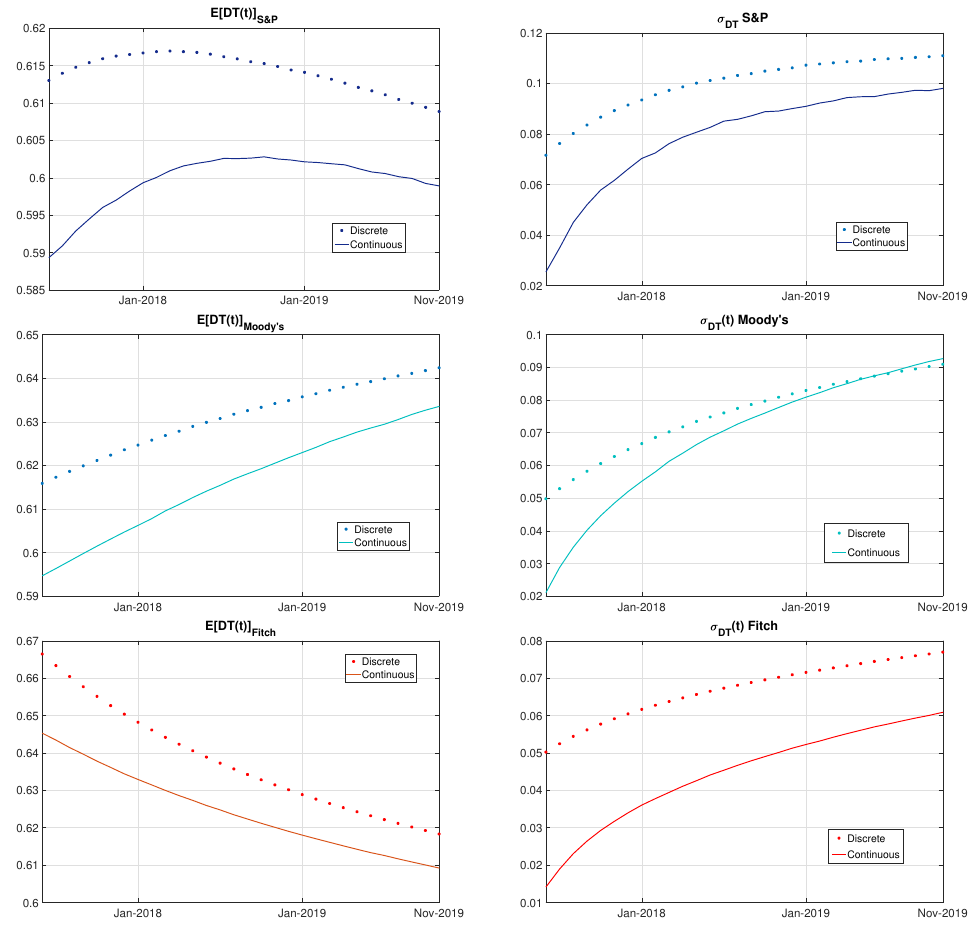
Figure 8. E [ DT ( t )] and σ DT ( t ) compared for discrete and continuous time